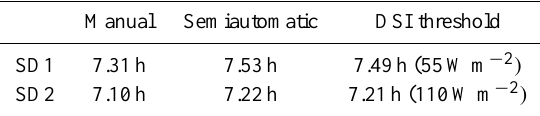
Figure 4. Scatter plots of the (a) daily SD obtained for CSSR1 from both SDaut (blue crosses) and SDman (red points) methods against SDpyr, considering the threshold of 120Wm − 2 in DSI; and (b) the daily SD obtained by the two CSSR using the automatic method. In each graphic we also represent the 1:1 line (black